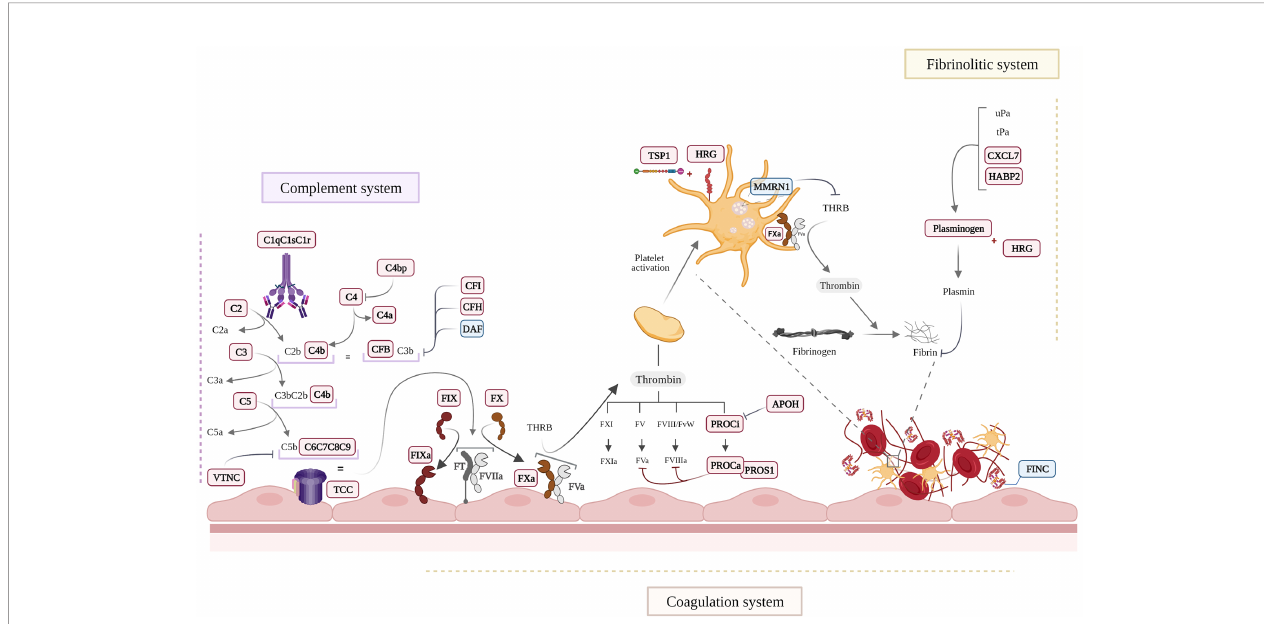
FIGURE 7 | Schematic view of the main molecular processes affected in EC-anaphylaxis. Proteins appearing as in bold and red are increased and those in blue were decreased in the EC-anaphylaxis